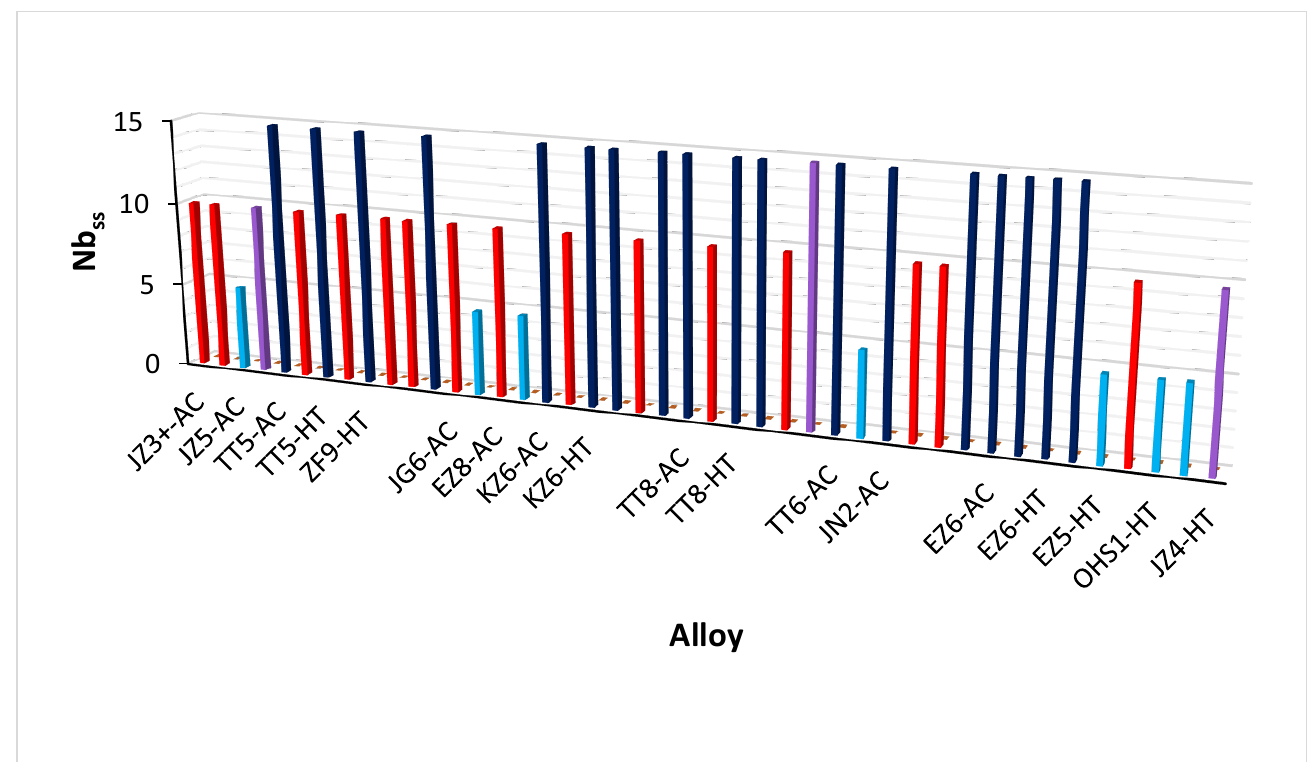
Figure 1. Nb ss in RM(Nb)ICs and RM(Nb)ICs/RCCAs with nominal Si content 18 at.% and alloying elements Al, B, Cr, Ge, Hf, Mo, Nb, Sn, Ta, Ti, W: “conventional” Nb ss (dark blue), CC/HE Nb ss (red), (iii) Nb ss with no Si (light purple) (iv) not stable Nb ss (light blue). For presentation purposes the numbers 15, 10 and 5 have been assigned, respectively, to “conventional” Nb ss , CC/HE Nb ss and not stable Nb ss . AC = as cast, HT = heat treated. For nominal alloy compositions and references see the